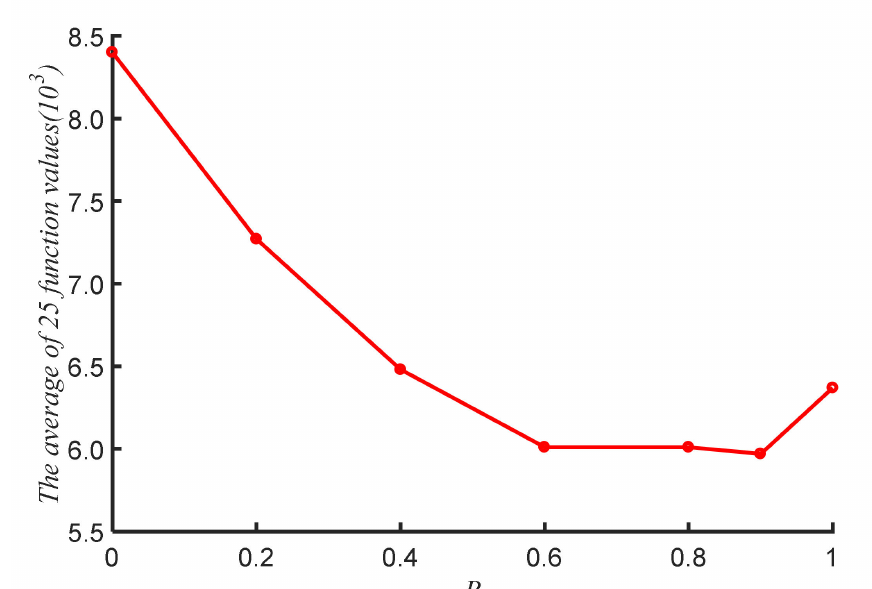
Figure 6. The average values of 25 function in different P